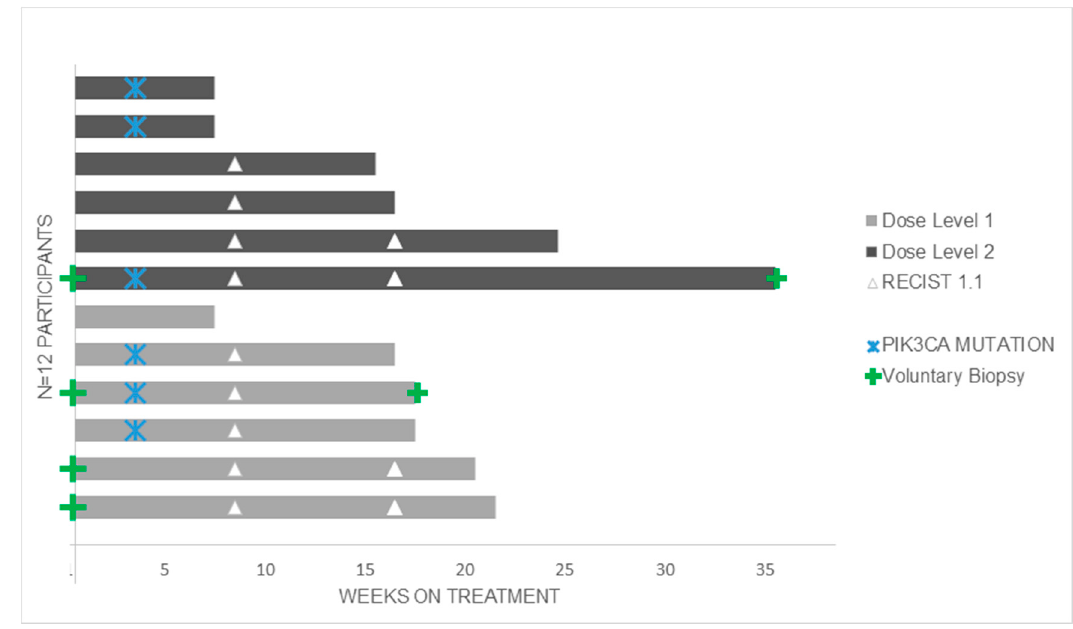
Figure 1. Time in weeks on copanlisib and trastuzumab.